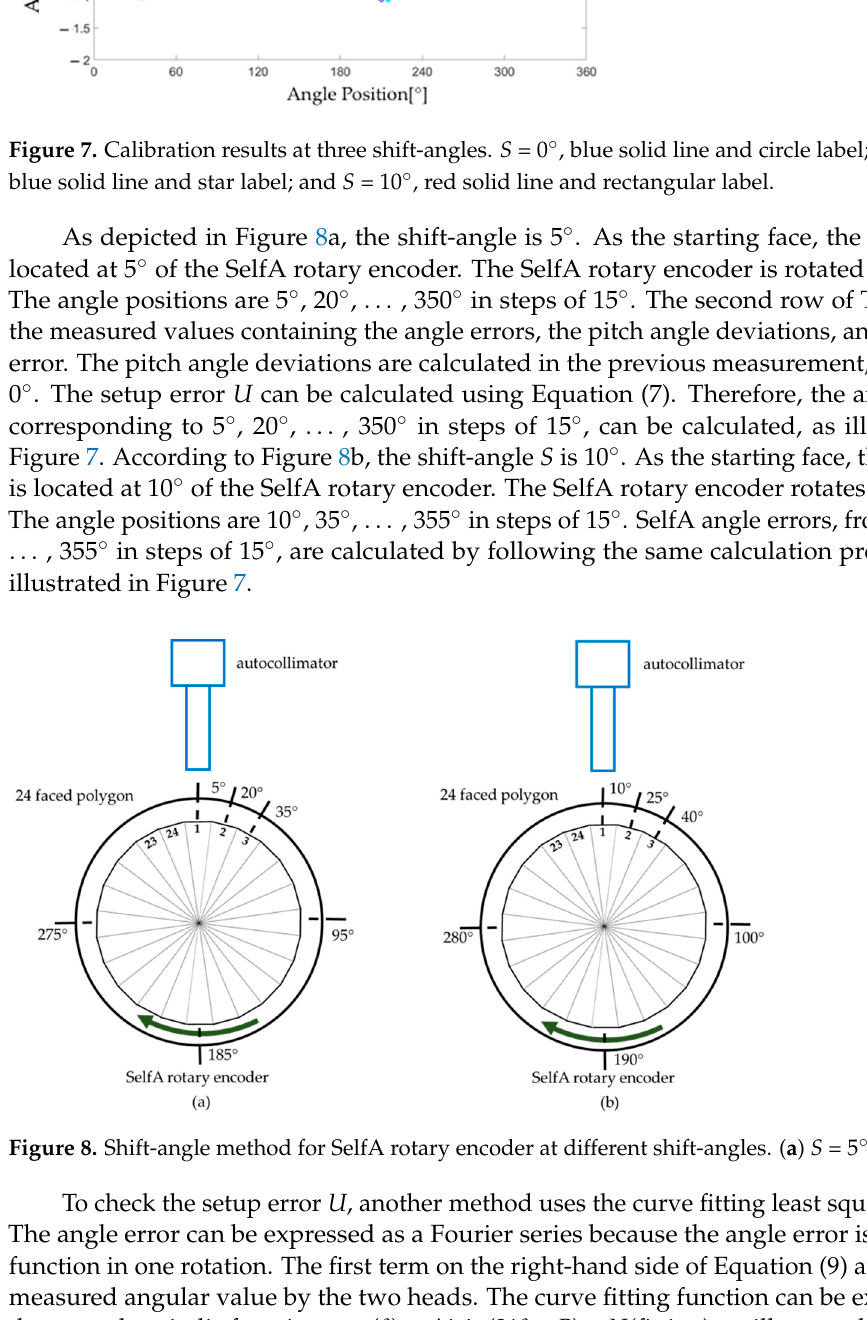
Figure 7. Calibration results at three shift-angles. S = 0 ° , blue solid line and circle label; S = 5 ° , light blue solid line and star label; and S = 10 ° , red solid line and rectangular label.